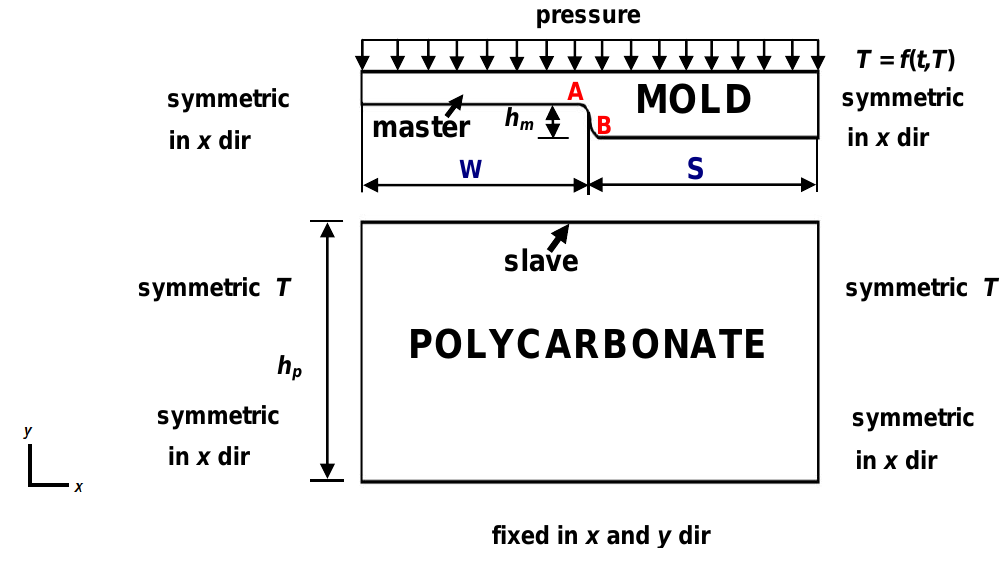
Figure 4. Computational scheme of the nickel mold hot imprint into